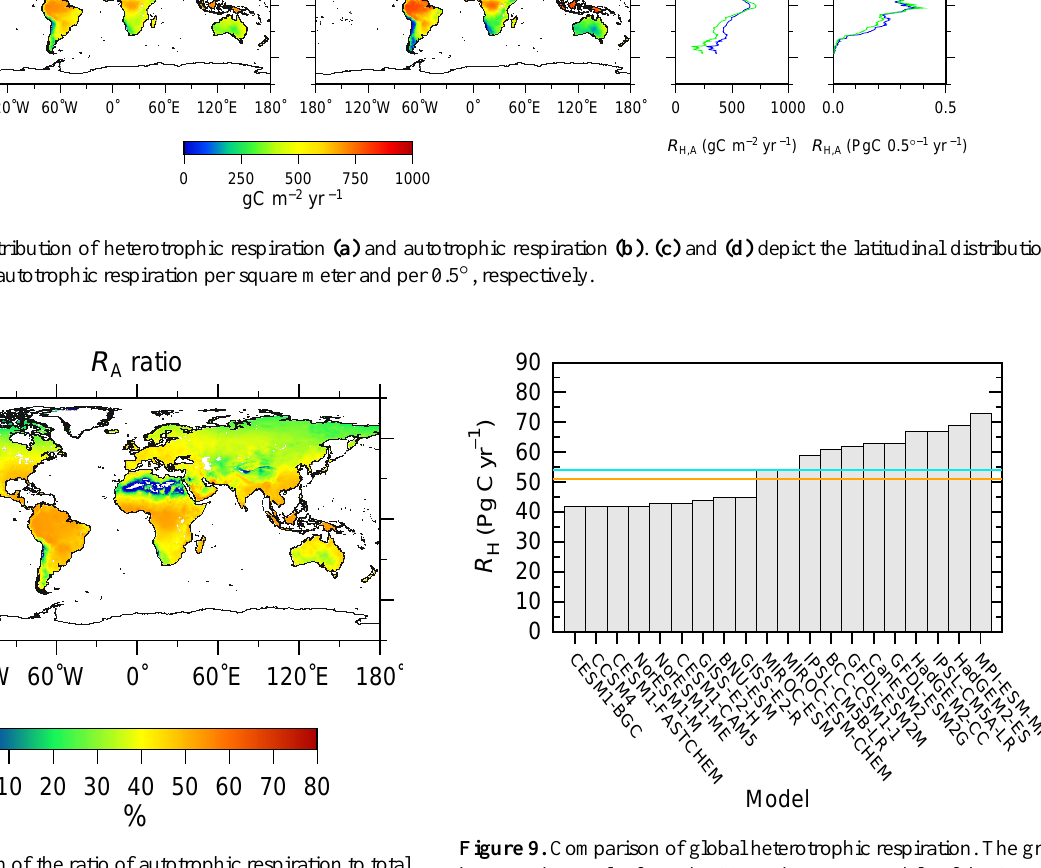
Figure 8. Distribution of the ratio of autotrophic respiration to total soil respiration.